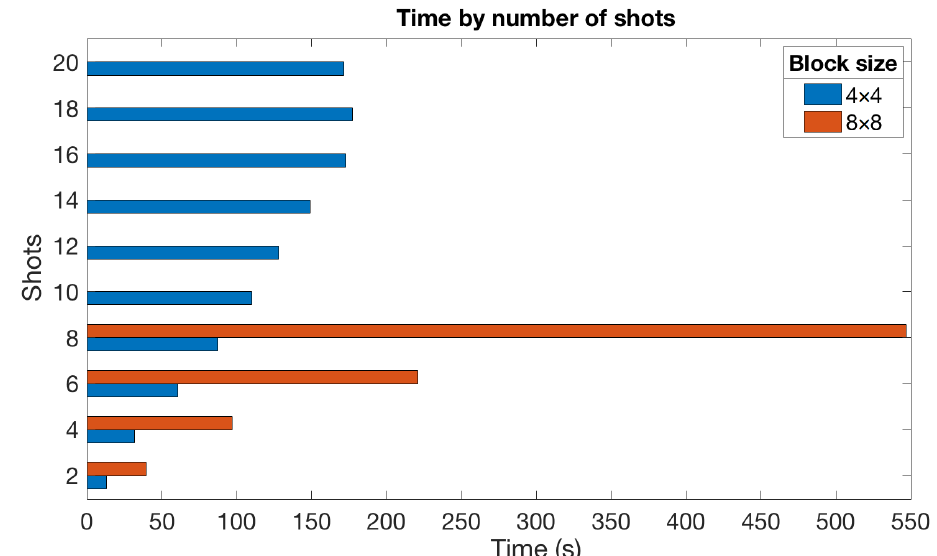
Figure 11. Execution time with different number of measurement shots and block